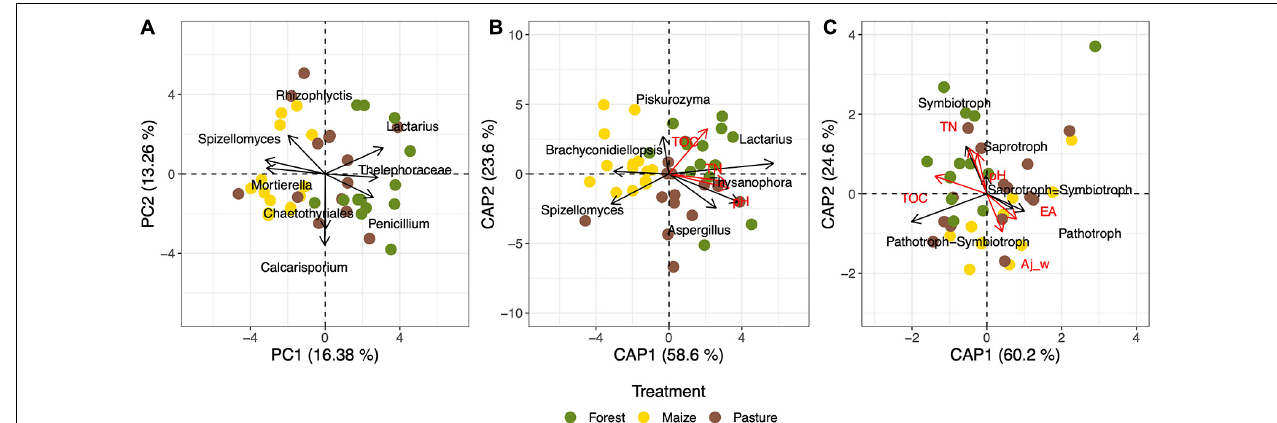
FIGURE 4 | Ordination analyses of the taxonomic composition and trophic groups of fungal communities in a coniferous forest soil (Forest), deforested for grazing (Pasture), and in maize ( Zea mays L.) cultivated deforested soil (Maize) at the “ Área de Protección de Flora y Fauna Nevado de Toluca ” (Mexico). Principal component analysis (PCA) of the fungal genera with prevalence > 20% of soils (A) ; constrained analysis of principal coordinates analysis (CAP) of the fungal genera with prevalence > 20% of soils and total organic carbon (TOC), total nitrogen (TN), and pH (B) ; and CAP with the trophic fungal groups and electrolytic conductivity (EC), clay content, TOC, TN, and pH (C)